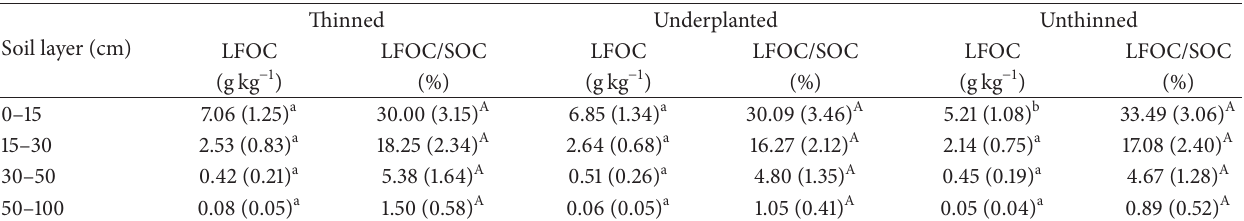
Table 3: Soil light fraction organic carbon content in thinned, underplanted, and unthinned stands (standard deviation in brackets); different letters in the same soil layer indicate there are significant differences among the three treatments (5% level, Duncan test), small letters denote the difference in LFOC, and capital letters denote the difference in LFOC/SOC.